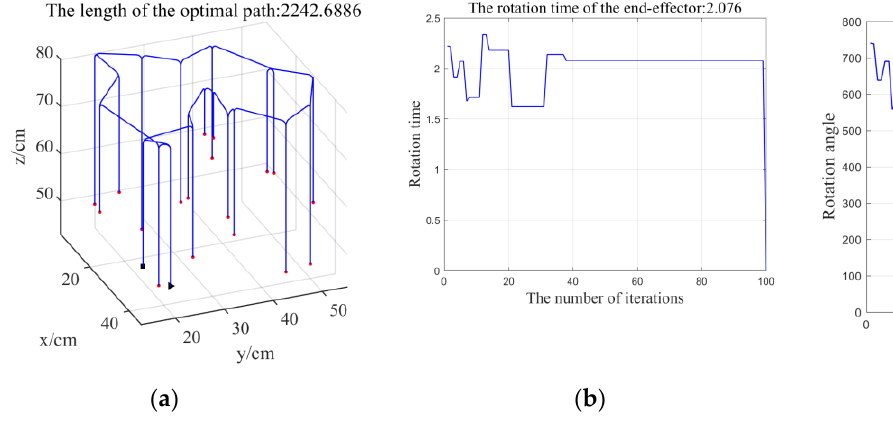
Figure 16. The fixed plane ∩ -shaped picking track planning results: ( a ) Simulation of picking path results; ( b ) Path length change curve; ( c ) Sum of waiting times of shortest paths.